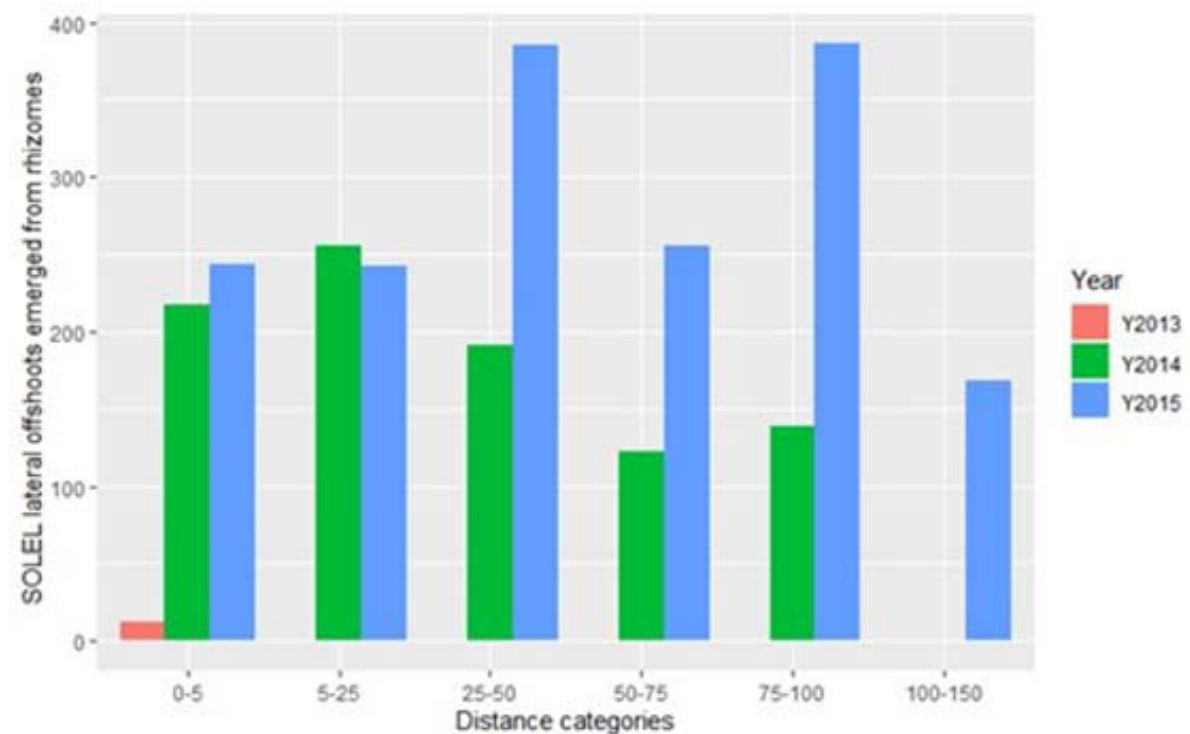
Figure 4. Solanum elaeagnifolium lateral offshoots number at six distance categories (0–5, 5–25, 25–50, 50–75, 75–100, and 100–150 cm) from parent shoots during three growing-cycles (2013, 2014, and 2015) in Chott Mariem.